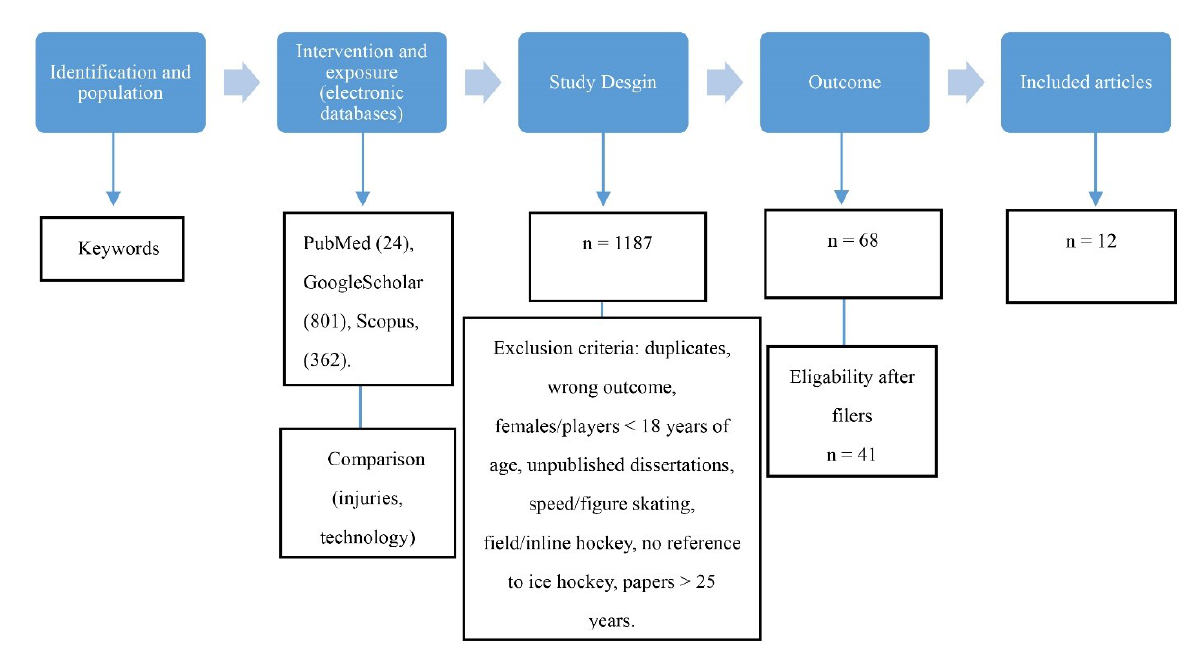
Fig. 1. Flow diagram of the search strategy and article selection